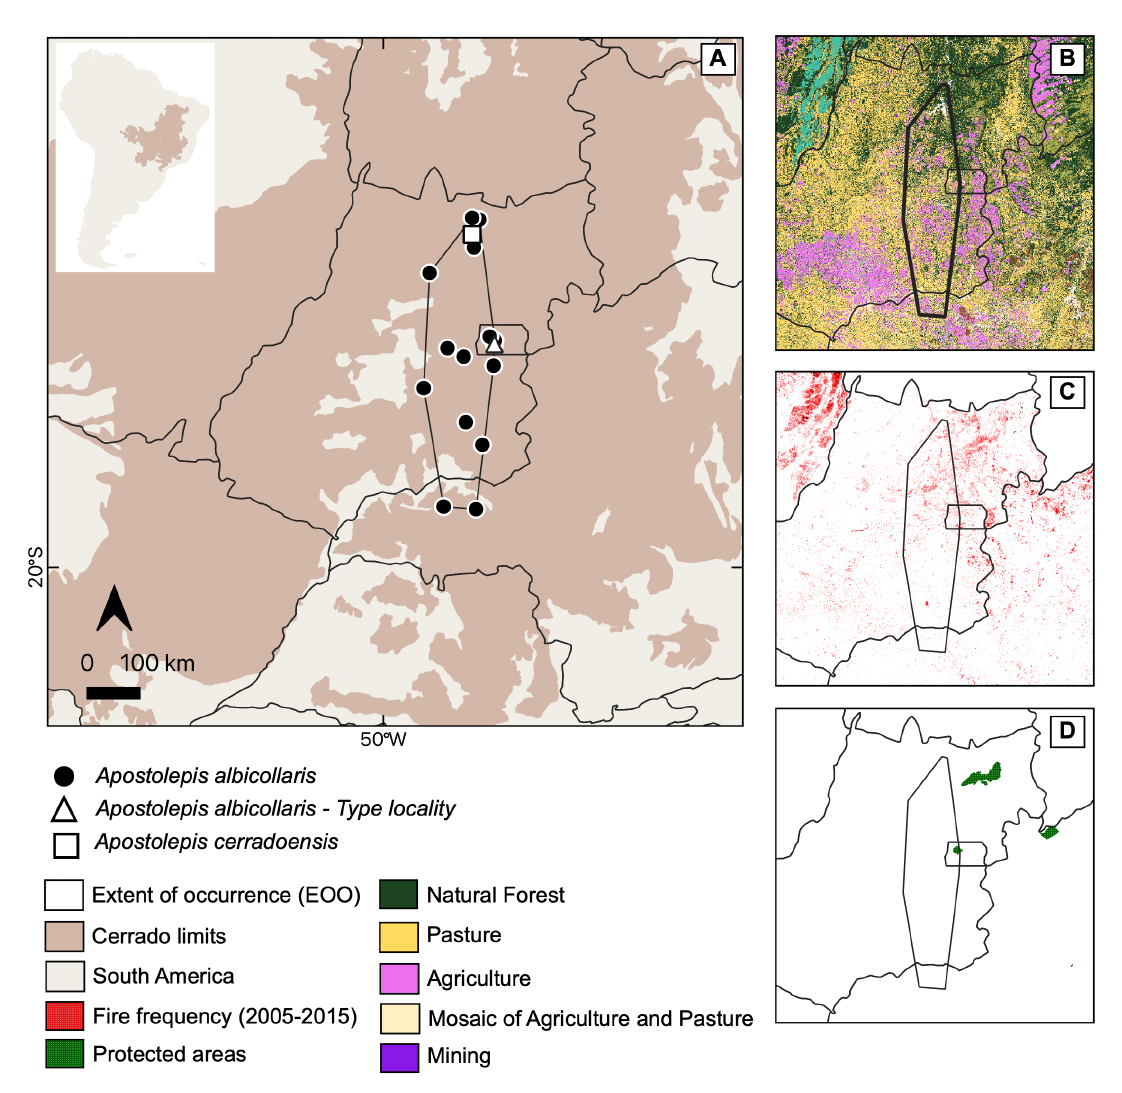
Fig. 7. Geographic distribution of Apostolepis albicollaris Lema, 2002 in the Cerrado of Central Brazil. A . Total range, with minimum convex polygon representing extent of occurrence. B . Natural habitat remnants and land use and land cover changes (collection 4, MapBiomas 2021) within the range of A. albicollaris . C . Fire frequency between 2005 and 2015 (collection 1, MapBiomas 2021) within the range of A. albicollaris . D . Protected areas (ICMBio 2021) within the range of A. albicollaris